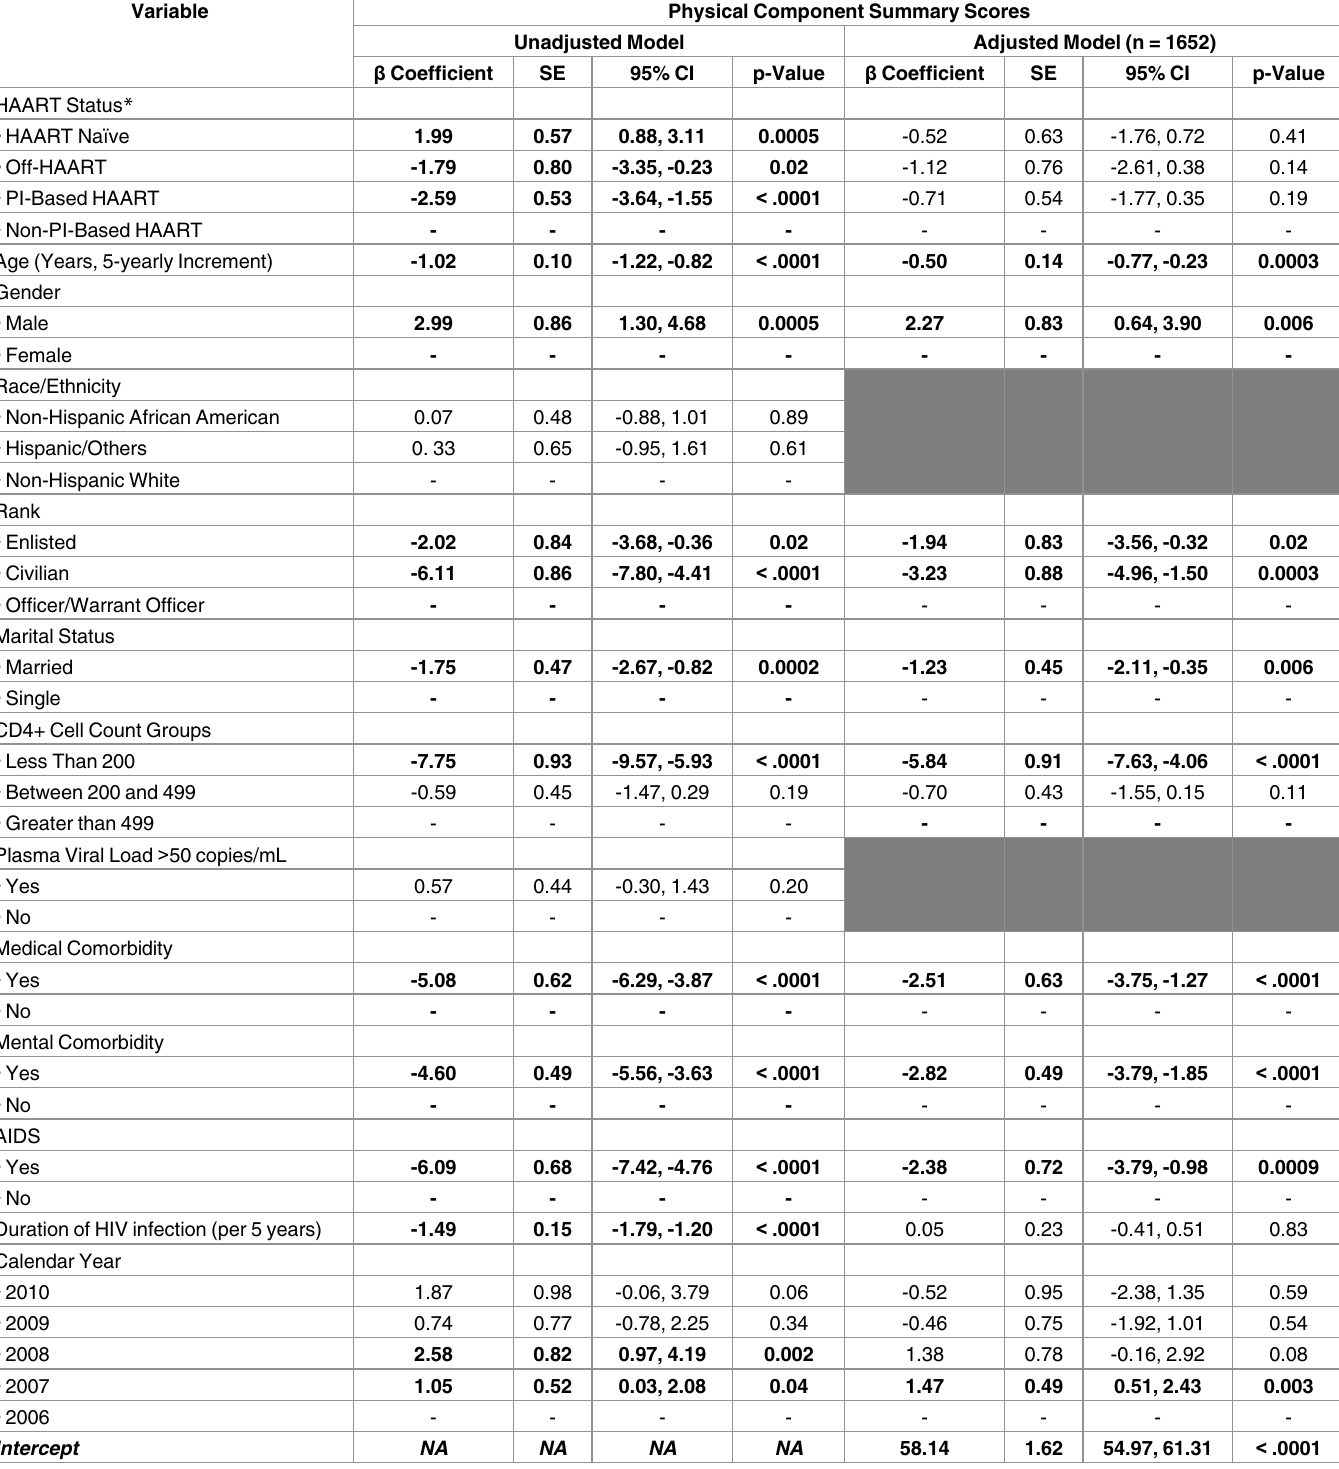
Table 3. Factors associated with physical component summaryscores at